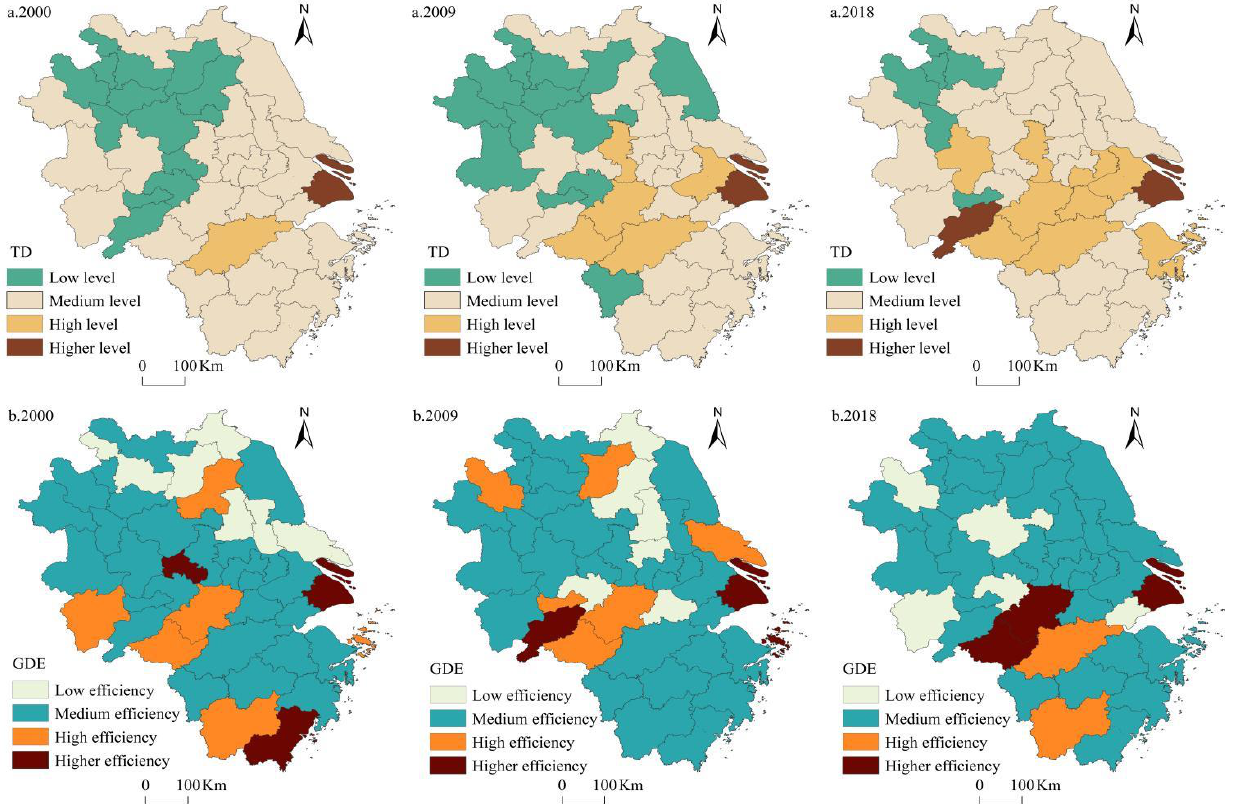
Figure 3. Spatial pattern of TD and GDE in the Yangtze River Delta region. Note: ( a ) represents the development level of TD in 2000, 2009 and 2018; ( b ) represents the development level of GDE in 2000, 2009 and 2018.